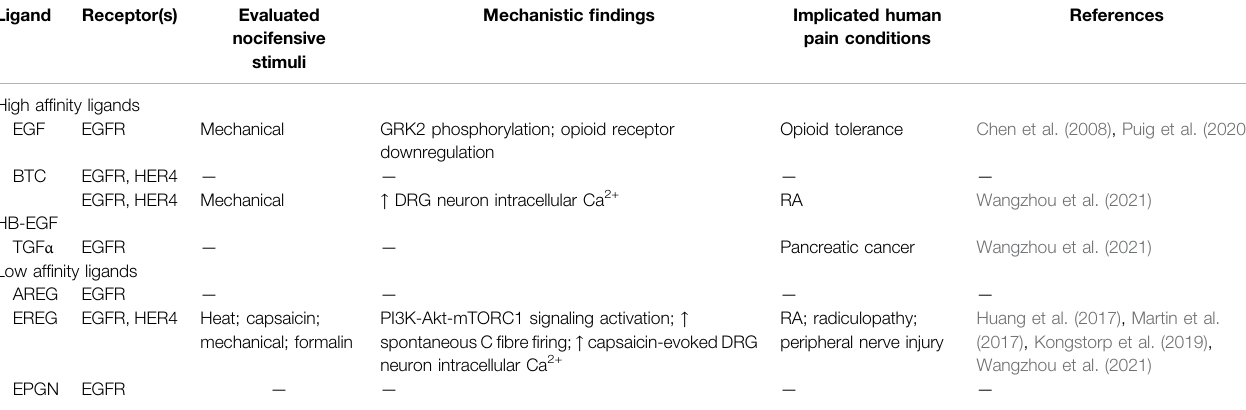
ExperimentalevidenceforandsuggestedrolesofEGFRligandsinpain.Evaluatednocifensivestimuli,mechanistic fi ndingsandhumanconditionsinwhichligandshavebeenimplicatedto contributeto pain areindicated.EGF: epidermal growthfactor,BTC:betacellulin,HB-EGF:heparin-bindingepidermal growthfactor-likegrowthfactor,TGF α :transforminggrowthfactor alpha,AREG:amphiregulin,EREG:epiregulin,EPGN:epigen.PGE2:prostaglandinE2.i.t.:intrathecal,DRG:dorsalrootganglion,RA:rheumatoidarthritis,SNI:sparednerveinjury,CFA: complete Freund ’ s adjuvant. — indicates no available data.